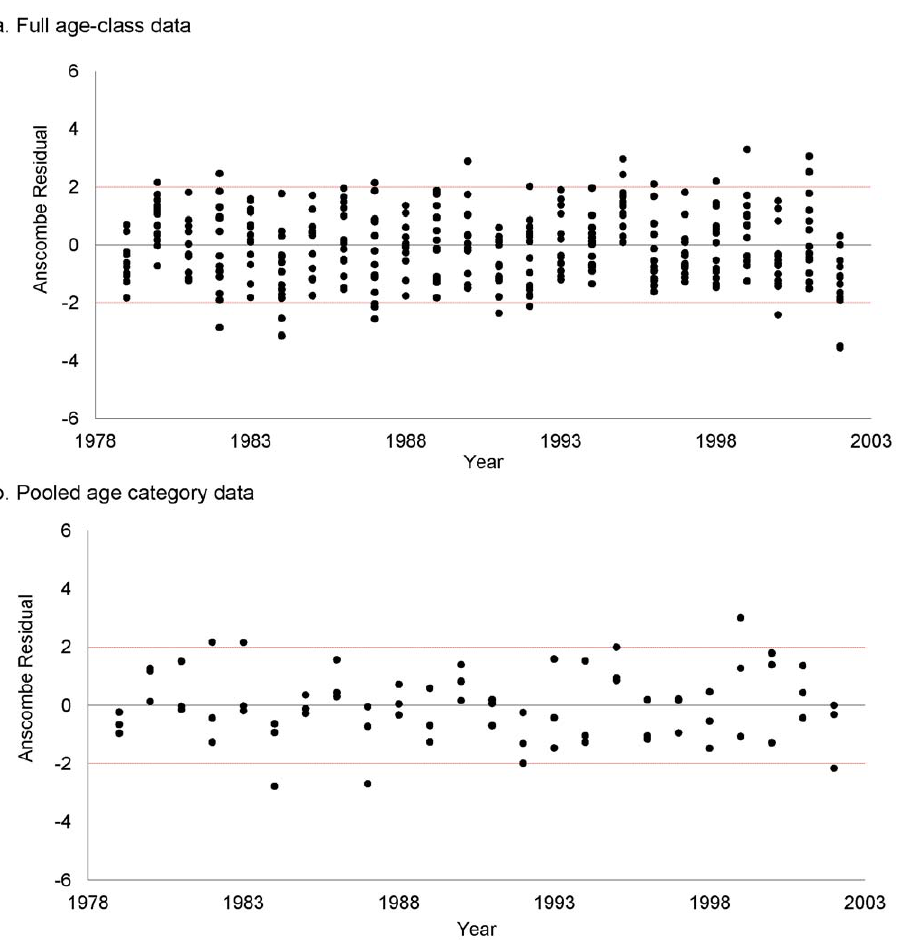
Figure 1. Standardized residuals [ 23 ] plotted by calendar year for the black-tailed deer population reconstruction using (a) full age- class data and (b) pooled age-class data (i.e., 0.5, 1.5, and 2.5 + ). a. Full age-class data. b. Pooled age category